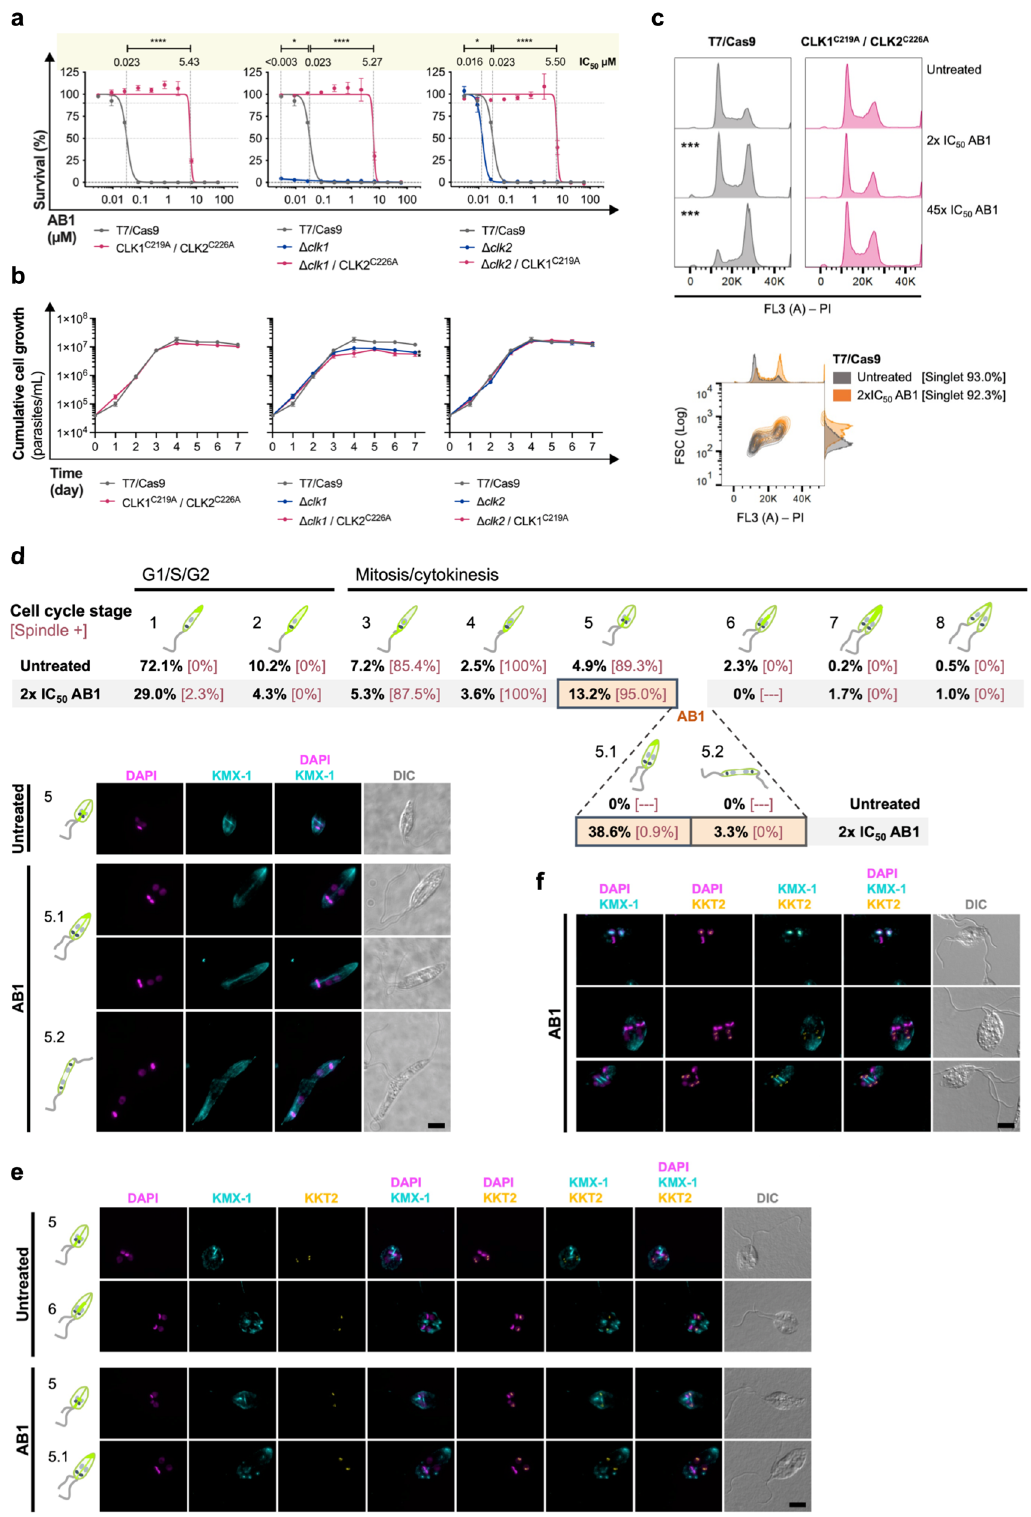
(Fig. 4e and Supplementary Fig. 8). Moreover, after 24 h treatment with AB1, most cells were multinuclear ( ≥ 4 nuclei): some with aneuploidy and some with the mitotic spindle, indicating they carried out further cycles of organelle replication despite the disruption of cytokinesis (Fig.